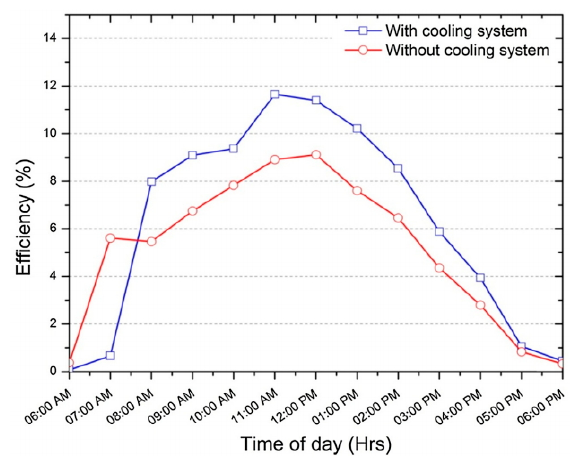
Figure 7. Photovoltaic e ffi ciencies of the PV modules with and without the cooling system. Reprint Figure 7. Photovoltaic efficiencies of the PV modules with and without the cooling system. Reprint Figure 7. Photovoltaic efficiencies of the PV modules with and without the cooling system. Reprint with permission from Reference [57]; 2015, Elsevier. with permission from Reference [57]; 2015, Elsevier. with permission from Reference [57]; 2015, Elsevier. Figure 7. Photovoltaic efficiencies of the PV modules with and without the cooling system. Reprint with permission from Reference [57]; 2015, Elsevier.